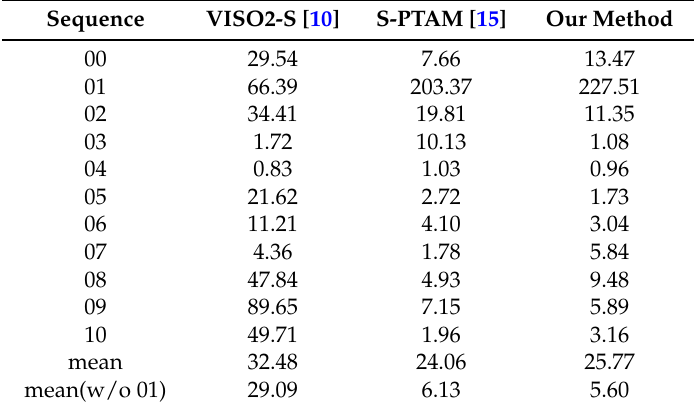
Table 6. Absolute trajectory error RMSE in